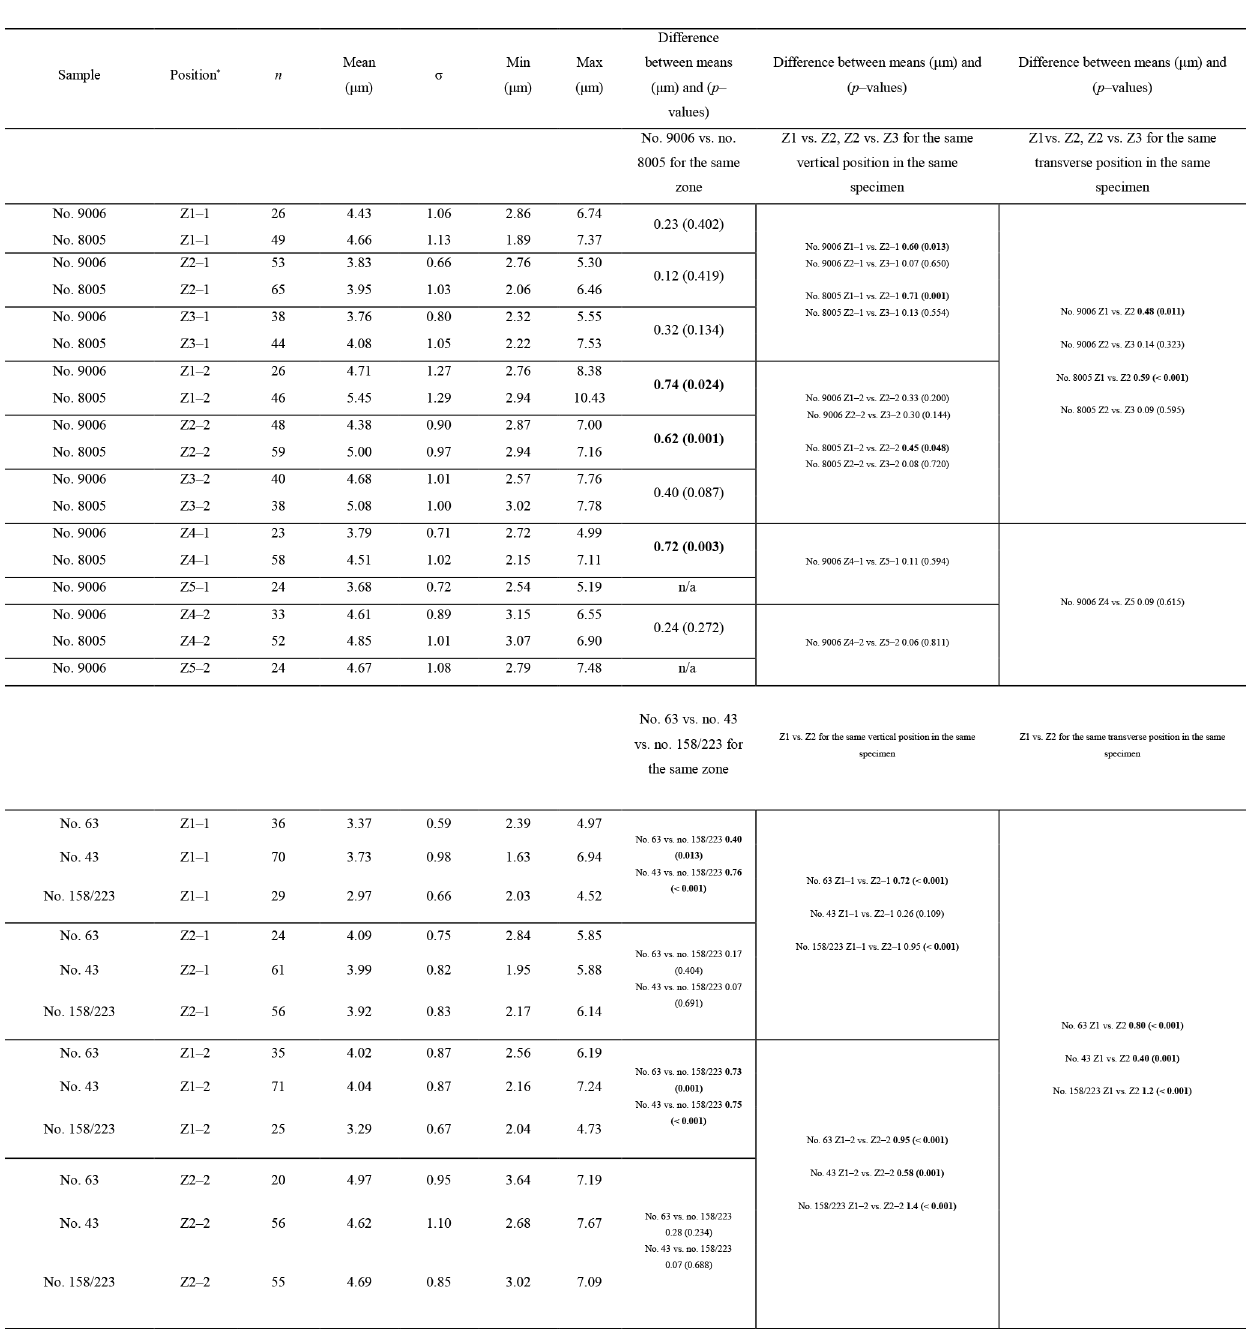
Table 10. Statistical comparison of fibre sizes of M. venosa (ventral and dorsal valve) in the anterior transverse sections ( during-culturing ). ∗ For the position of zones (Z1-1, Z2-1, Z3-1, Z1-2, Z2-2, Z3-2, Z4-1, Z5-1, Z4-2, Z5-2), see Fig. 9. Significant values ( p -value ≤ 0 . 05) are marked in bold. “n/a” stands for not